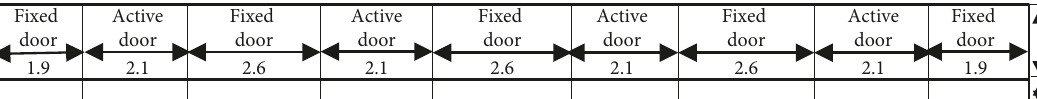
Figure 6: Size of semihigh shield door (unit: m).